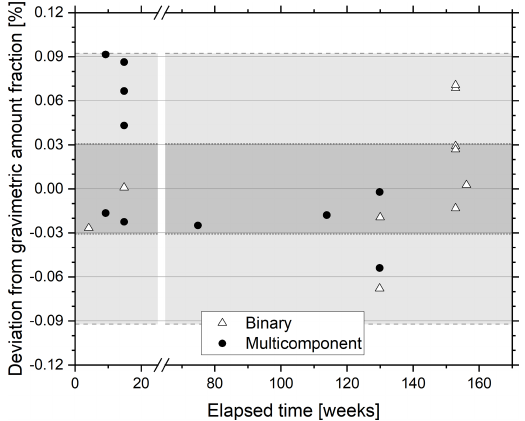
Figure 4. Percentage difference between gravimetric and certified N 2 O amount fraction of a 325nmolmol − 1 reference material as a function of storage time. The reference material was certified against freshly prepared N 2 O reference materials in the amount fraction range 320–360nmolmol − 1 . The freshly prepared reference materials were either diluted in synthetic air (open triangle) or con- tained other greenhouse gases (filled circle). The WMO-GAW com- patibility goal is indicated on the plot in dark grey shading, and the extended compatibility goal is indicated by lighter grey